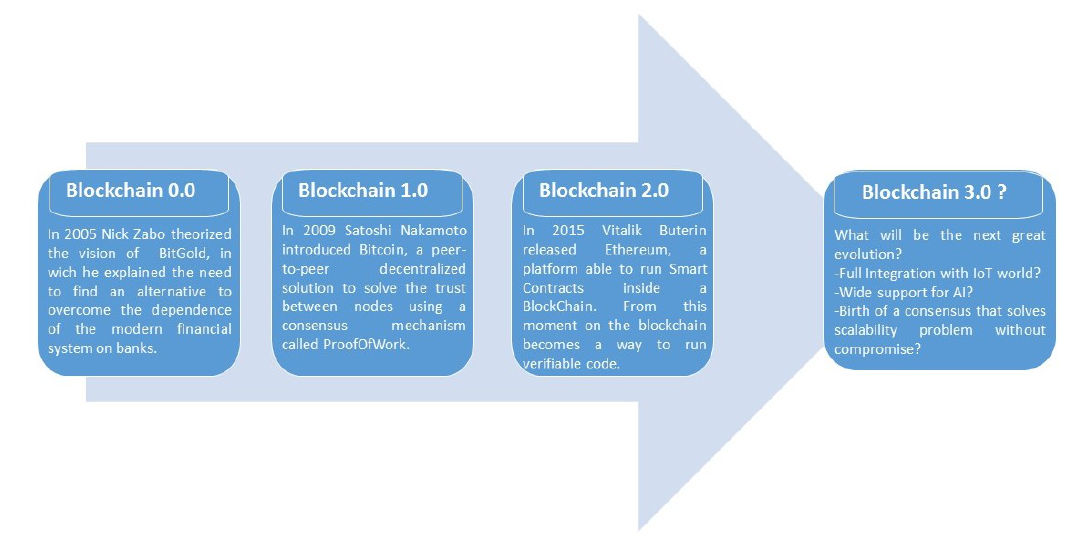
Figure 2. Blockchain